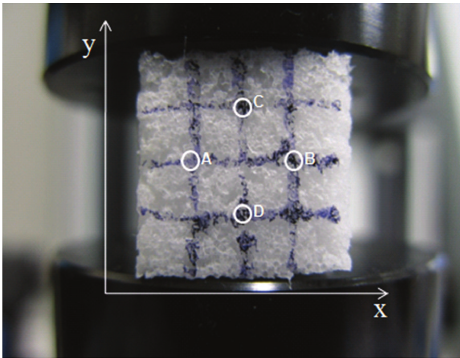
Figure 3: Experimental setup with microscope for capturing the specimen while applying a load to measure the displacement of the specimen with the points (A to D).